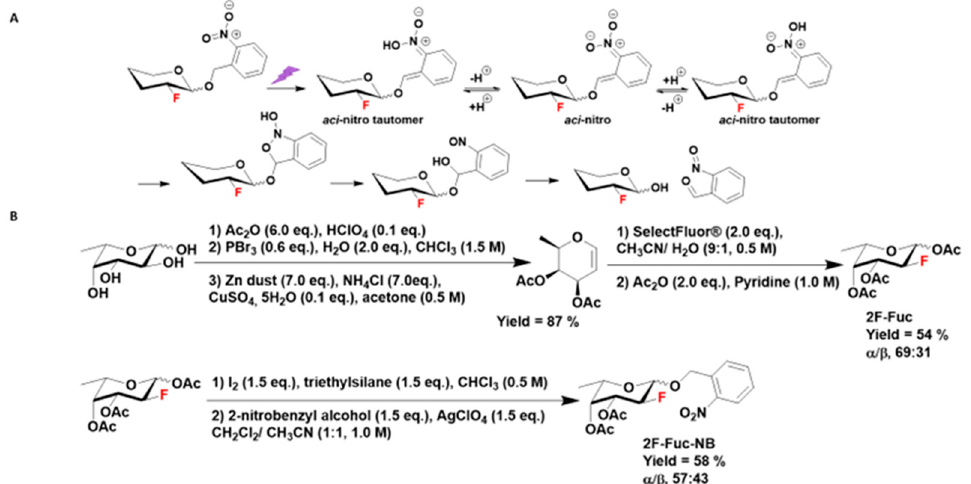
Figure 2. ( A ) Photoirradiation of 2-fluoro sugar caged by an ortho -nitrobenzyl alcohol on the anomeric carbon results in the release of free 2-fluoro monosaccharide and ortho -nitrosobenzaldehyde through aci -nitro intermediates. ( B ) Chemical synthesis of 3,4-di- O -acetyl-1- ortho -nitrobenzyl-2-fluoro- L -fucose (2F-Fuc-NB).